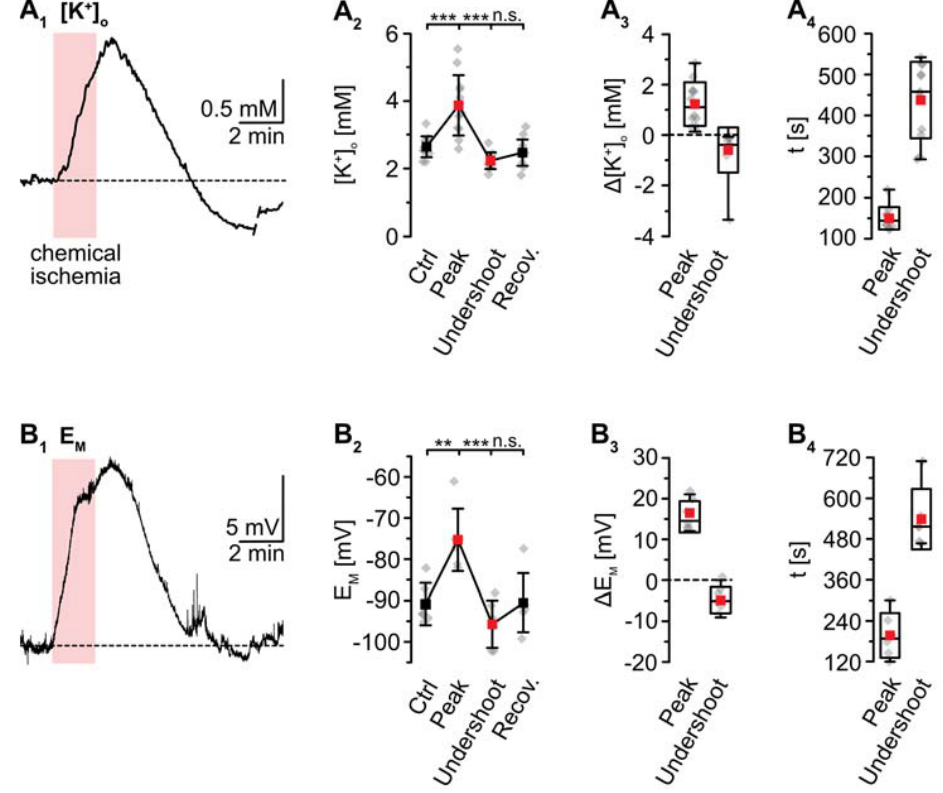
Figure 3. Ischemia-induced changes in [K + ] o and astrocytic membrane potential. ( A ) [K + ] o. ( A 1 ): Increase in [K + ] o in an individual measurement. ( A 2 ): Plot illustrating baseline [K + ] o , peak changes in [K + ] o , undershoot and subsequent recovery. Shown are individual data points (grey diamonds), means (squares), and SDs (whiskers). ( A 3 , A 4 ): Box plots illustrating peak changes in [K + ] o ( A 3 ) as well as the time-to-peak and time-to-undershoot ( A 4 ). ( B ) Same illustration as in ( A ) for changes in astrocytic E M . ( B 1 ): Individual measurement. ( B 2 ): Plot illustrating baseline E M , peak changes in E M , hyperpolarization, and subsequent recovery. ( B 3 , B 4 ): Box plots of peak changes in E M ( B 3 ) and the time-to-peak and time-to-undershoot ( B 4 ). Box plots in ( A 3 , A 4 ) and ( B 3 , B 4 ) show individual data points (grey diamonds), means (squares), medians (horizontal lines), SDs (boxes), and min/max (whiskers). ( A 2 , B 2 ): ** p < 0.005, *** p < 0.0005 (Šid á k corrected significance levels), n.s.: not